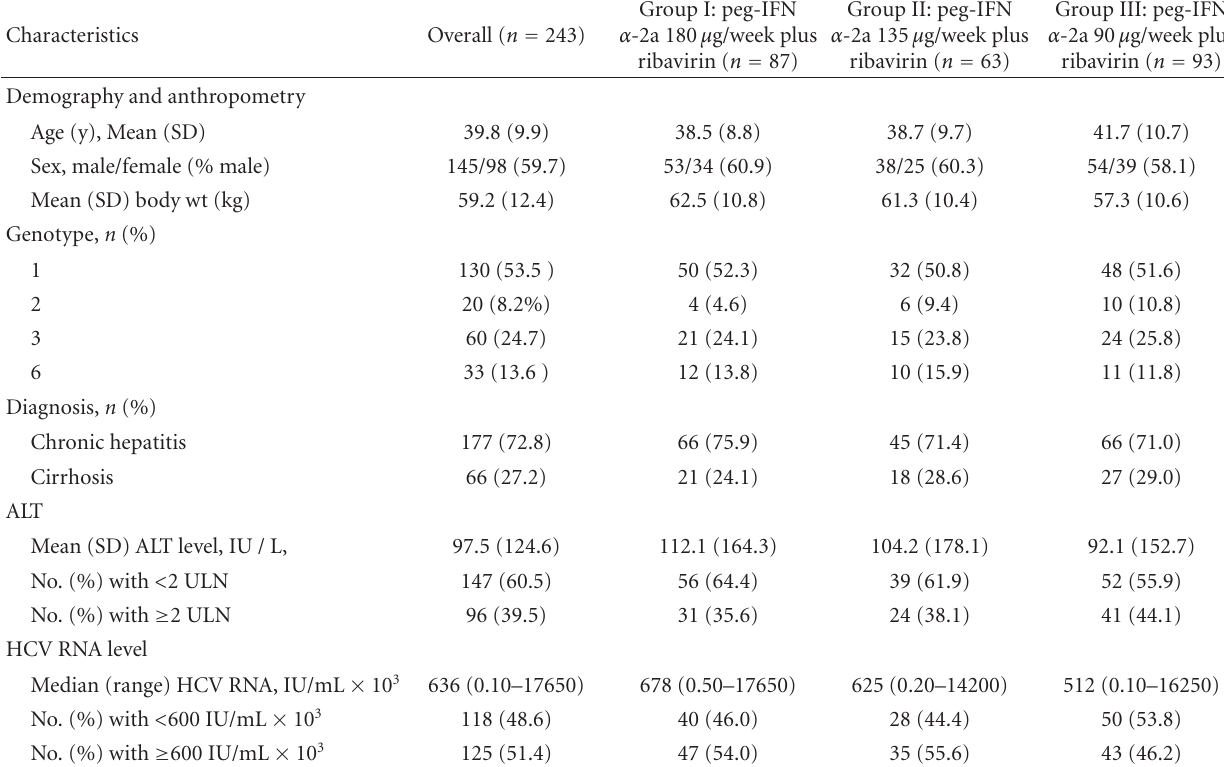
Table 1: The baseline characteristics of the patients.